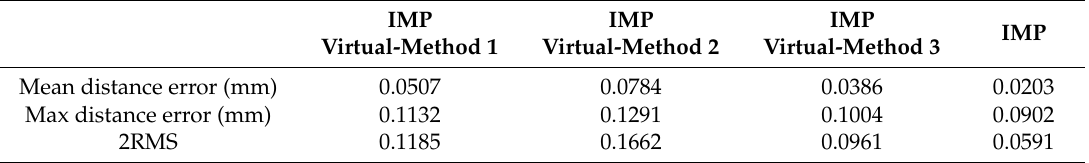
Table 8. Distance error results in AACMM verification with IMP (with and without virtual distances).